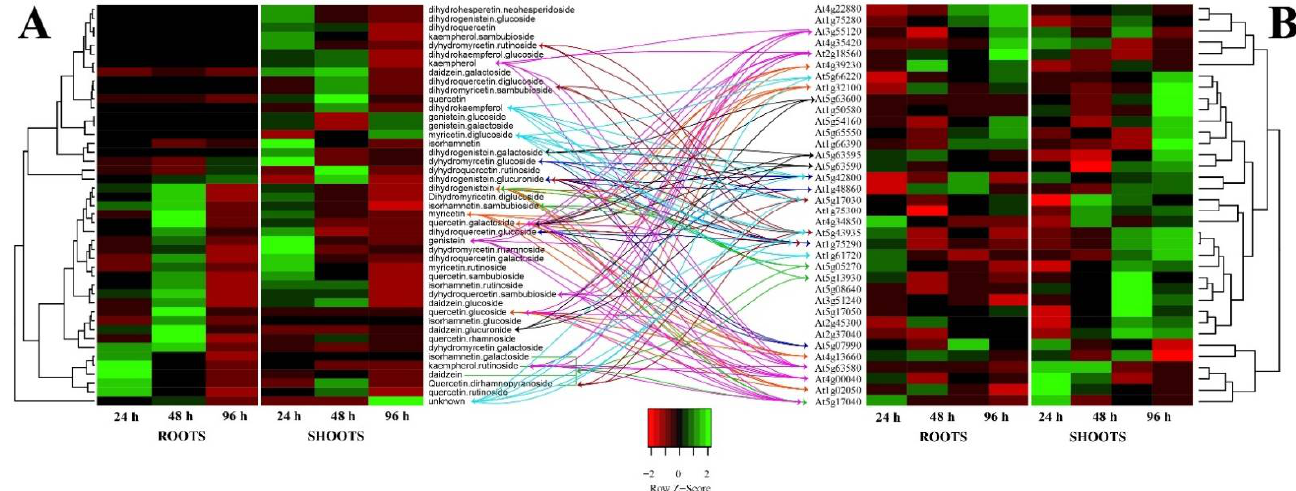
Figure 5. Direct comparison of heatmaps of polyphenols fold change obtained from data of Table 9 (Panel ( A )) and fold change of selected genes involved in polyphenols’ metabolisms obtained from Supplementary Table S7 (Panel ( B )). The heatmap was generated by using a single linkage clustering method and a Pearson distance measuring method. Downregulated genes are marked in red-shaded colors, whereas upregulation is evidenced by different shades of green. See text for arrow color specifications.